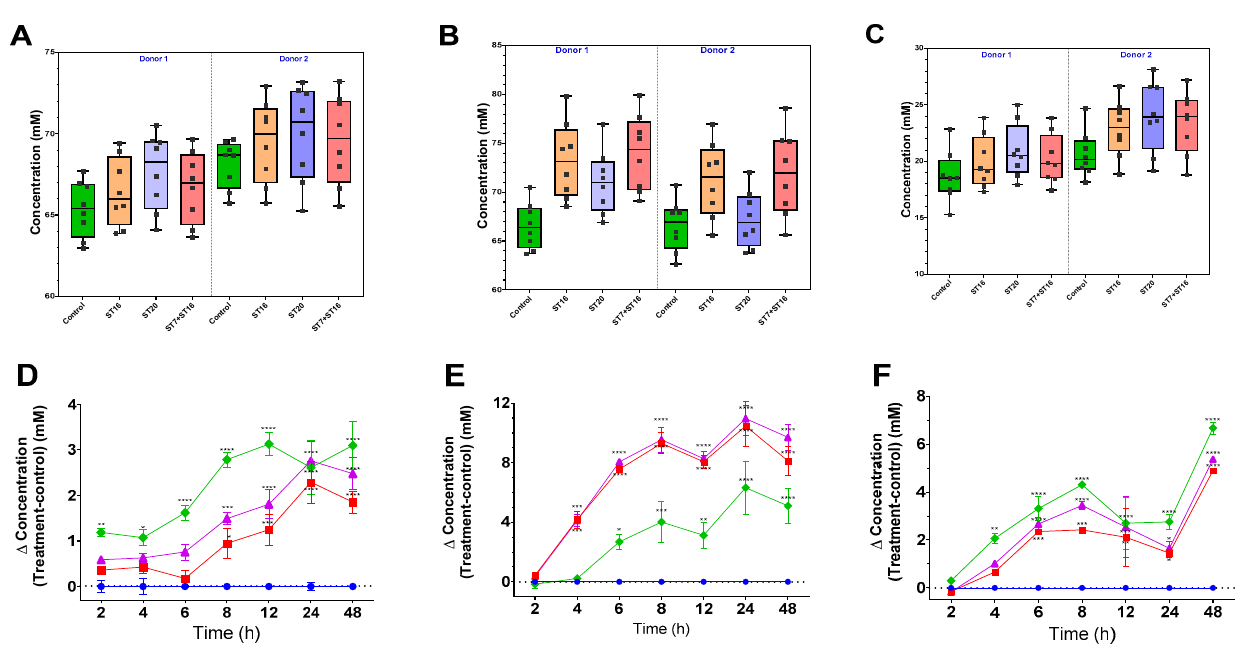
Figure 7. Concentration (panels ( A – C ); separated by donor) and concentration fold increase over control (panels ( D – F ); combined datasets) ( ∆ concentration = test-treatment − control) of short-chain fatty acids (SCFAs) measured by GC over 48 h: butyrate ( A , D ), acetate ( B , E ), and propionate ( C , F ) from top to bottom for each time point, with two biological replicates for donors 1 and 2 ( A – C ) over 48 h. Control (circle, blue); treatment with ST20 (diamond, green); treatment with ST16 (square, red); and treatment ST16 in combination with ST7 (triangle, purple). Statistical comparisons were conducted using repeated measures 2-way ANOVA test with Dunnett’s multiple comparisons test. Significant differences were indicated for each time point compared to the control time (* p < 0.05, ** p < 0.01, *** p < 0.001, **** p < 0.0001).